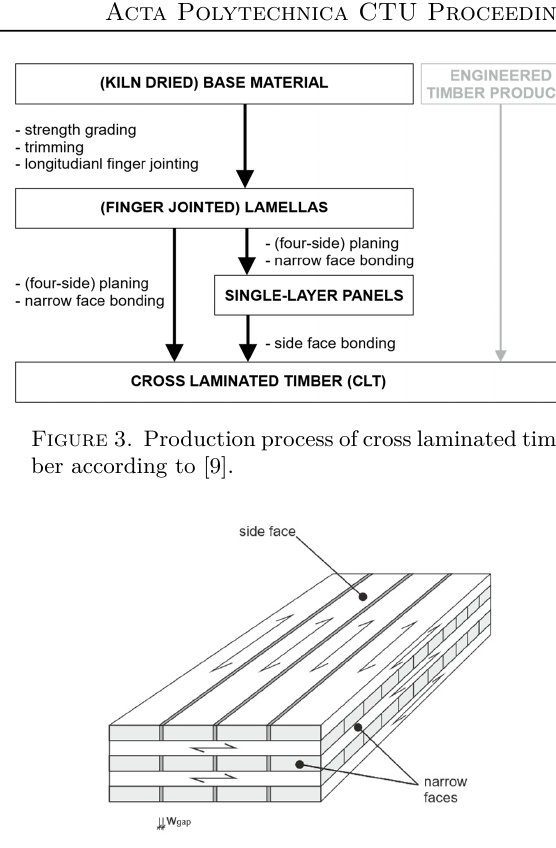
Figure 4. Simplified technical drawing of a CLT element according to